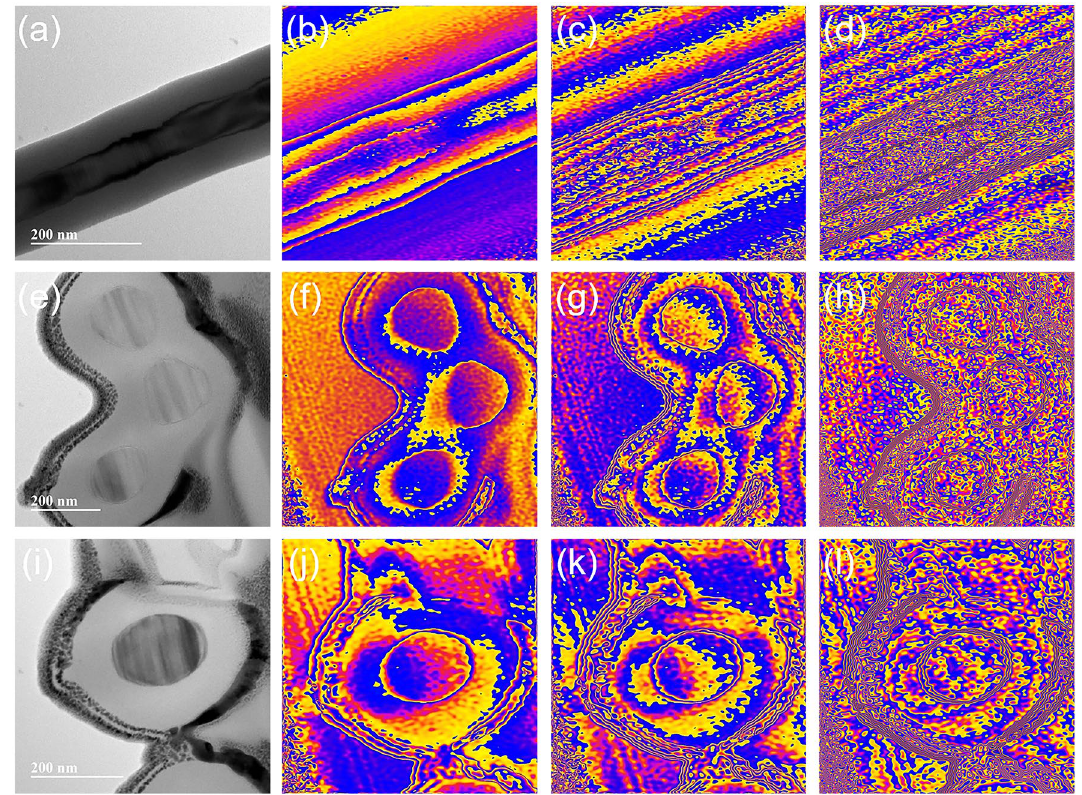
Fig. 9 Off-axis electron holography images of the SiC@SiO 2 NFA. a TEM image and b–d charge density images of the longitudinal section of a SiC@SiO 2 nanofiber. e TEM image and f–h charge density images of the transverse section of a junction node. i TEM image and j–l charge density images of the transverse section of a SiC@SiO 2